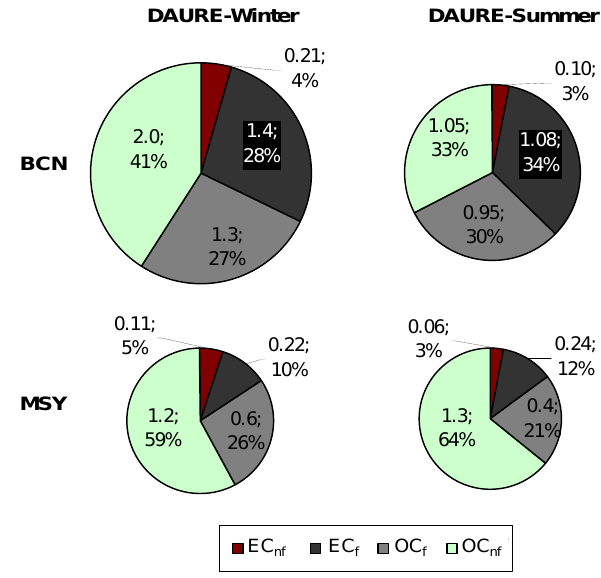
Figure 1 Fig. 1. Fossil (f) and non-fossil (nf) fractions of total carbon; con- centrations in µgm − 3 and % of total carbon.